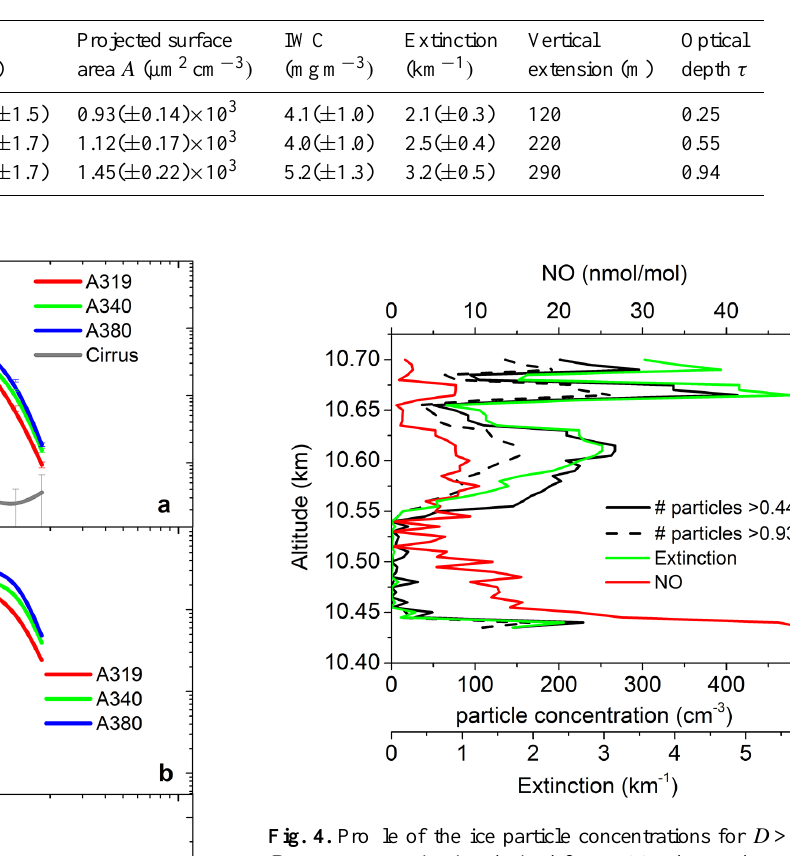
Table 2. Microphysical, macrophysical and optical properties of the selected contrail sequences from A319, A340 and A380 aircraft, derived from FSSP-300 measurements. Mean particle number density ( D >0.93µm), effective diameter D eff , projected planar surface area A p , ice water content IWC, vertical extension and optical depth τ are given for the three aircraft.